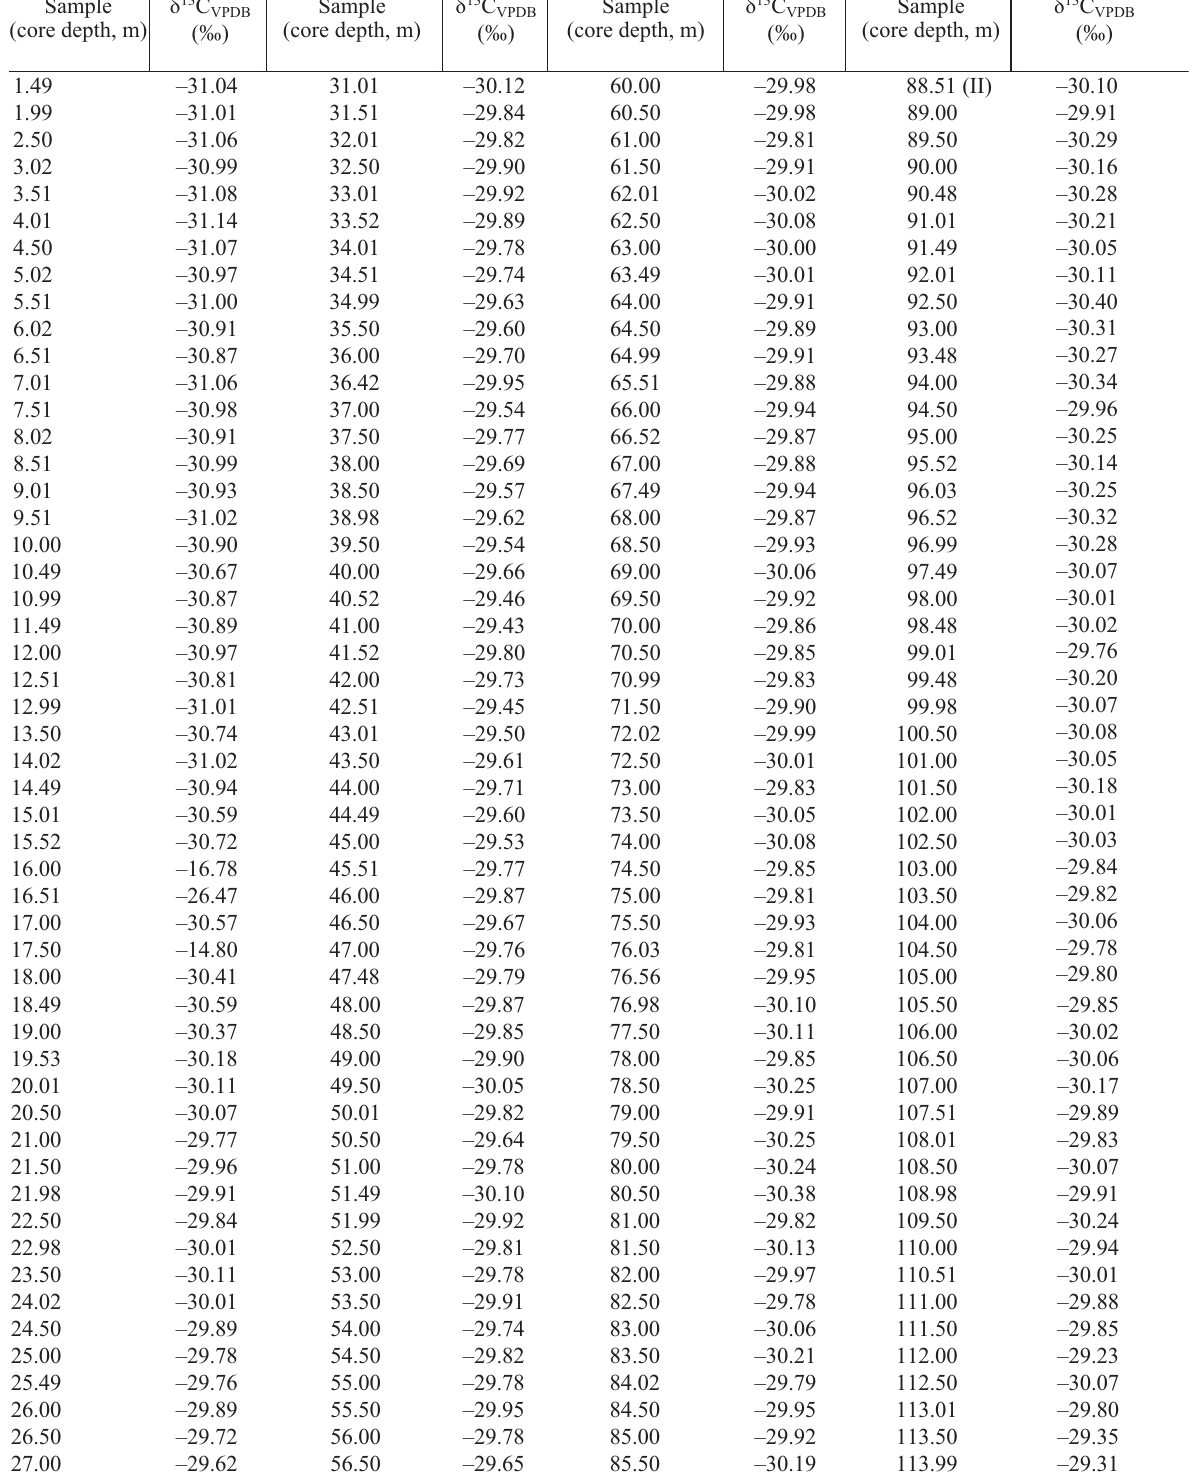
Table 1. List of study samples from the Röstånga­2 drill core showing δ 13 C org (‰ VPDB)